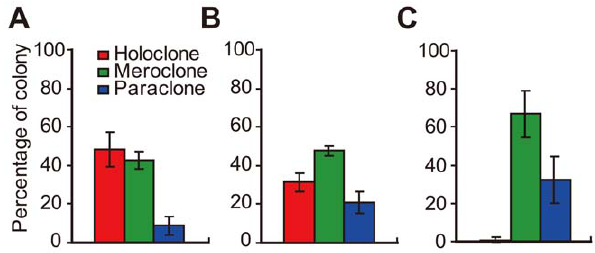
Figure 2. Self-renewal capacity of distinct types of colonies. Cells isolated from single colonies were plated at low density under common condition. (A) At the initial passage, holoclones (n=8) mainly produced similar frequencies of descendant holoclones and mero- clones, whereas much lower percentages of paraclones were generat- ed. (B)After passages of one more month, holoclones (n=8) generated the full range of progeny colonies at frequencies similar to those retained in unsorted parental cell lines. (C) Meroclones (n=8) mainly produced paraclones and meroclones, and few holoclones were